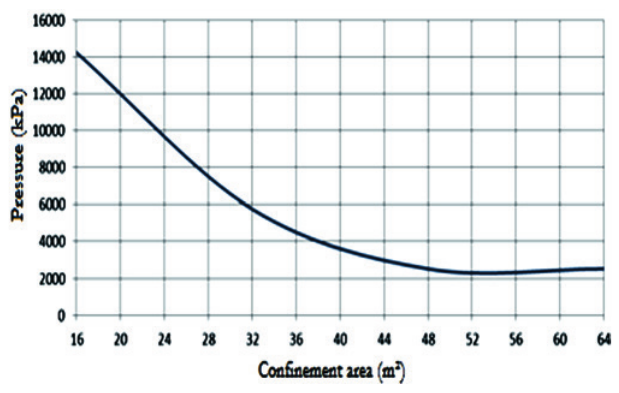
Blast wave overpressure vs confinement